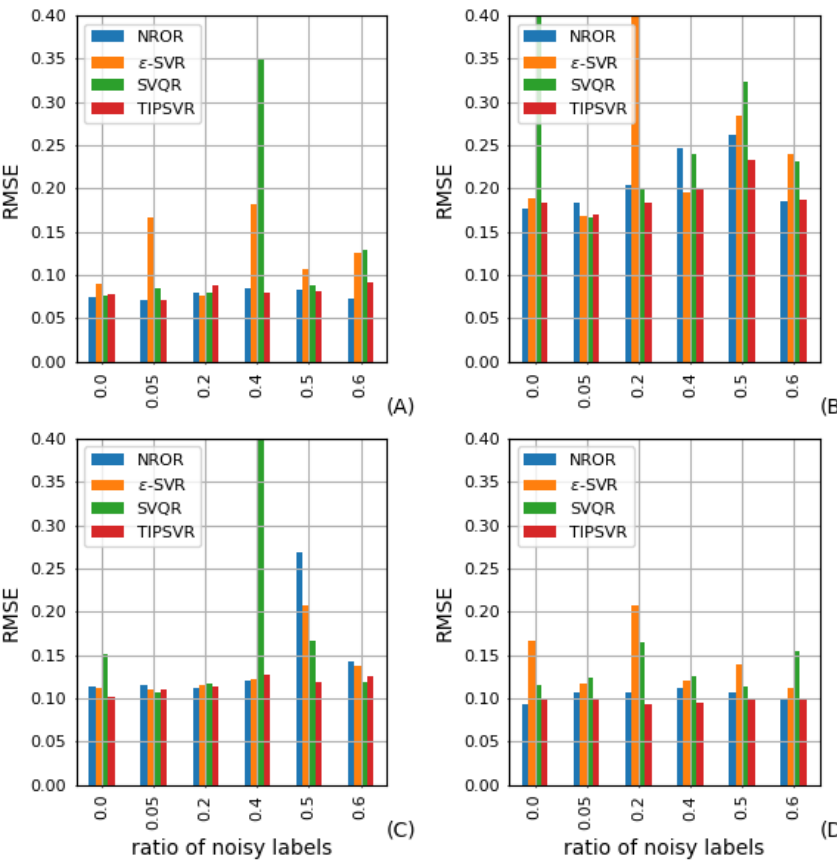
Figure 6. RMSE for noise of homogeneity on ( A ) CCPP, ( B ) DB, ( C ) EGSSD, ( D )